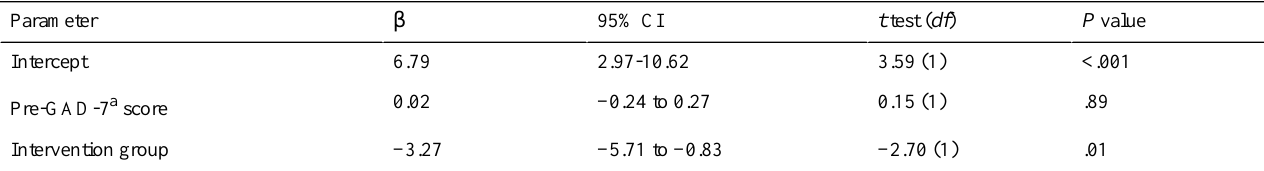
Table 2. Adjusted postintervention anxiety score (dependent variable) and treatments using analysis of covariance.